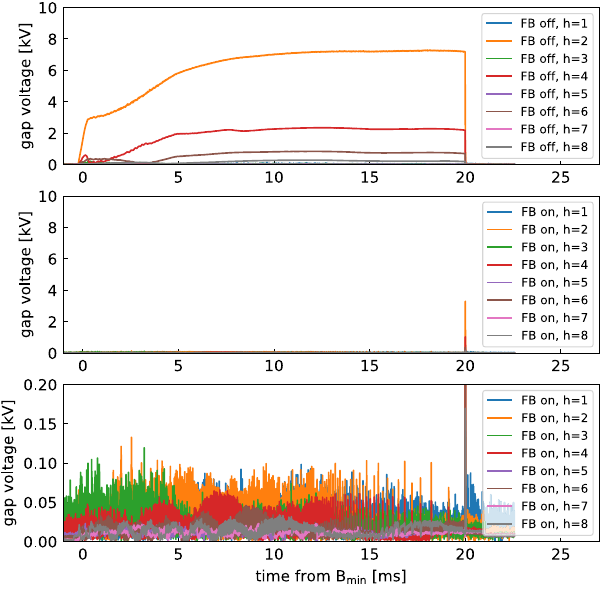
FIG. 31. Harmonic components of the gap voltage during acceleration of a single bunch (top) without feedback and (middle) with feedback and (bottom) a vertically magnified view of the middle